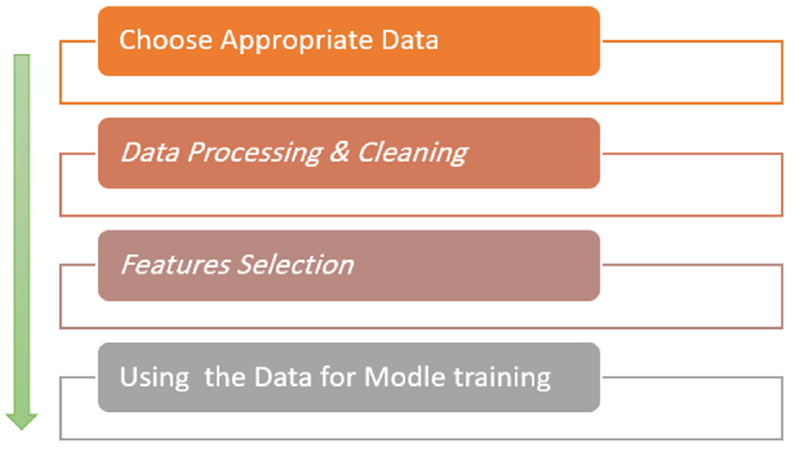
Figure 5. Data processing steps.